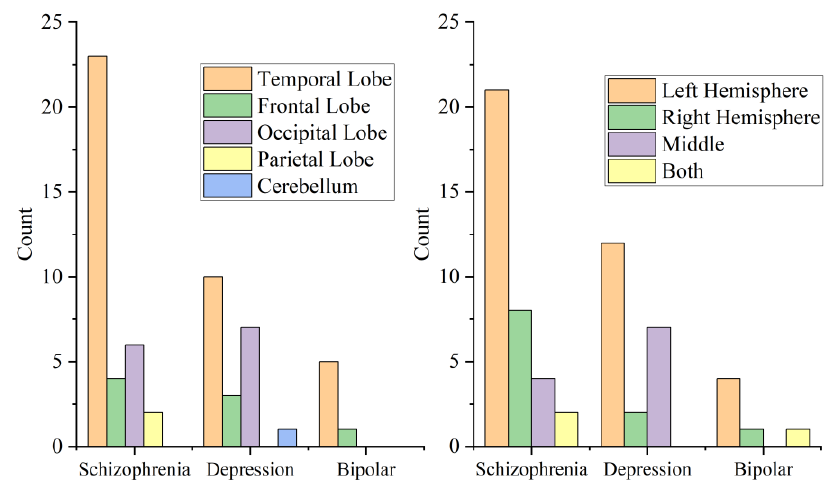
Figure 1. This is a figure that shows the location of brain regions or hemisphere where the cysts were located in patients with different